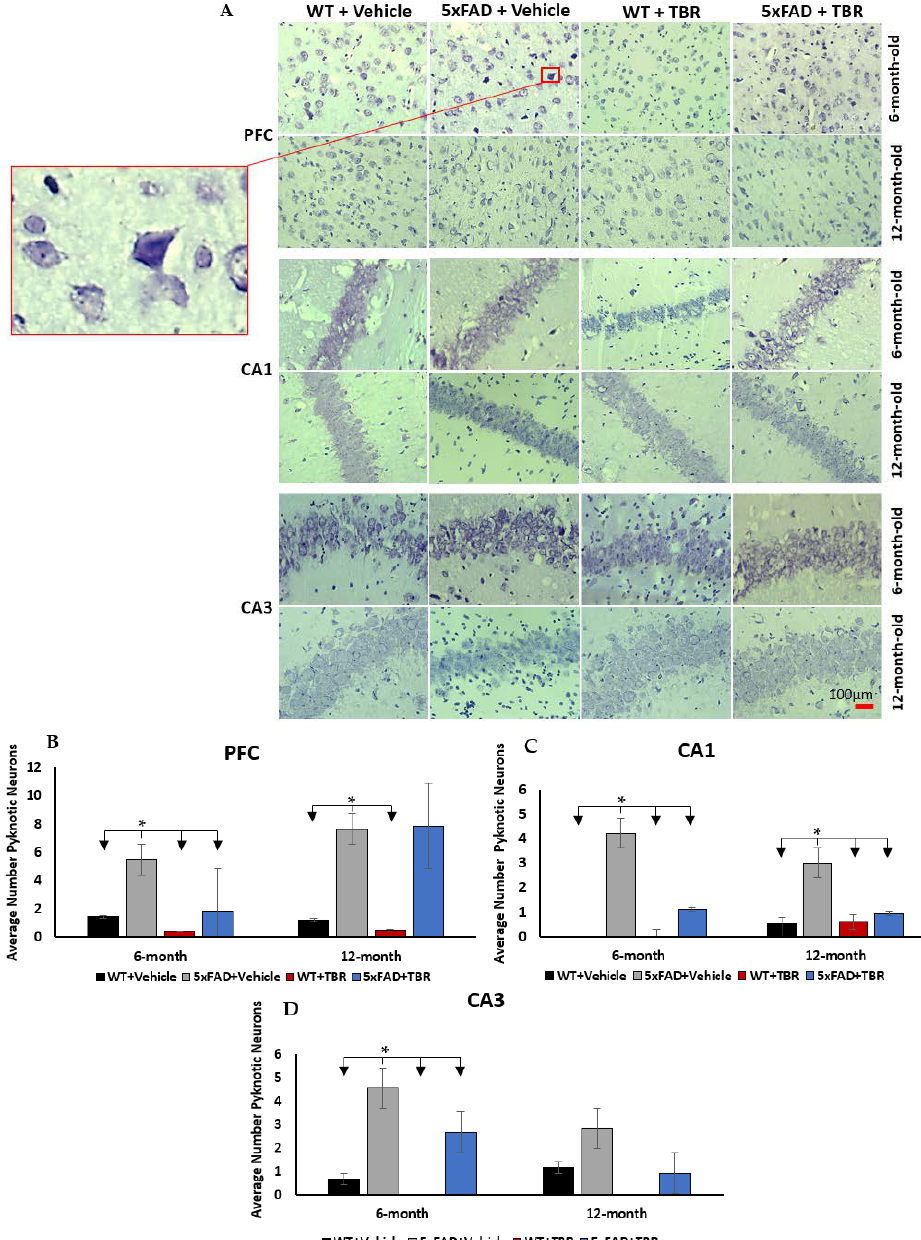
Figure 9. TBR treatment decreased pyknotic and tangle-like cells in the PFC and hippocampus of 5xFAD mice. ( A ) The 6- and 12-month-old 5xFAD and age-matched control mice were treated with (60 mg/kg BW) or vehicle for 2 months. ( B ) There was a significant difference in the number of pyknotic cells for 6- and 12-month-old mice in the PFC. ( C ) There was a significant difference in the number of pyknotic cells for 6- and 12-month-old mice in the CA1 area of the hippocampus. ( D ) In the CA3 area of the hippocampus there was a significant difference in the number of pyknotic cells for the 6-month-old animals but not for the 12-month-old mice. * p < 0.05.